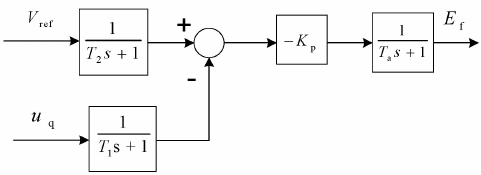
Figure 1. The excitation system model of the diesel